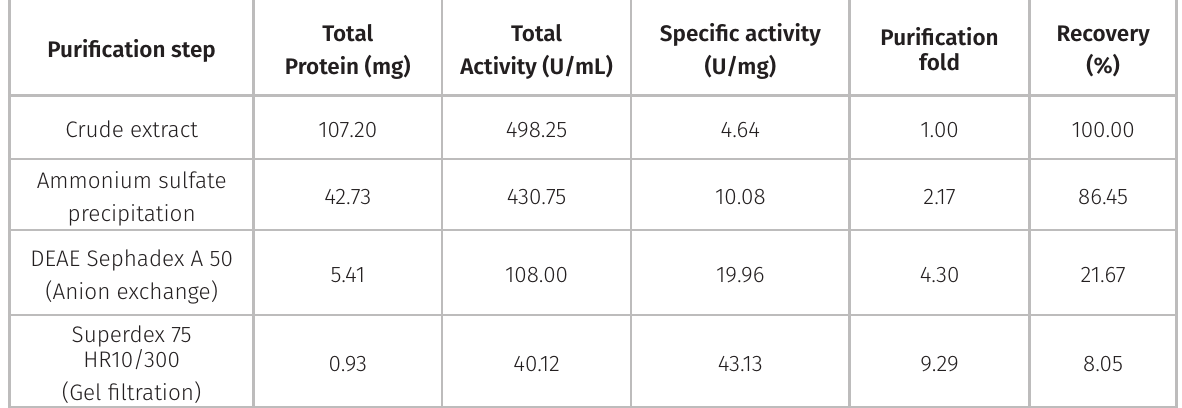
Table II. Purification protocol adopted for purification of fibrinolytic protease from Mucor subtilissimus UCP 1262 and related